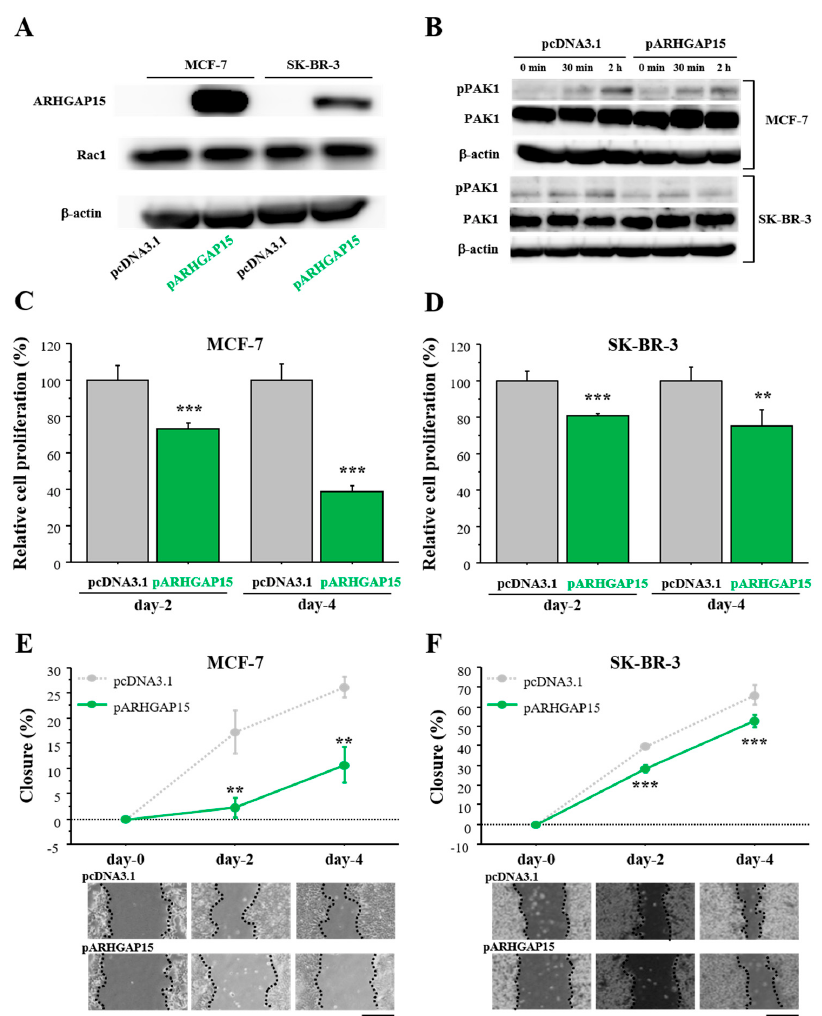
Figure 3. Effects of ARHGAP15 on Rac1 activation, proliferation, and migration of breast carcinoma cells. ( A ) Expression of ARHGAP15 protein in MCF-7 cells and SK-BR-3 cells transfected with ARHGAP15 expression vector (pARHGAP15) or vacant vector (pcDNA3.1). ( B ) MCF-7 (upper panel) and SK-BR-3 cells (lower panel) were transfected with ARHGAP15 expression vector or vacant vector, followed by stimulation with HRG (10 ng/mL) for the indicated time in serum-free conditions. ( C , D ) Relative cell proliferation of MCF-7 cells ( C ) and SK-BR-3 cells ( D ) transfected with pARHGAP15 was summarized as the ratio (%) to those transfected with vacant vector (2 days and 4 days after transfection). ( E , F ) Wound healing assays in MCF-7 cells ( E ) and SK-BR-3 cells ( F ). Relative migration area was evaluated as the ratio (%) to those at the removal of culture inserts (0 h). Scale bar is 500 μ m. Data were presented as mean ± standard deviation (SD). ** p < 0.01 and *** p < 0.001. Lower panels show representative micrographs in each period. PAK1: p21 (RAC1)-activated kinase 1.